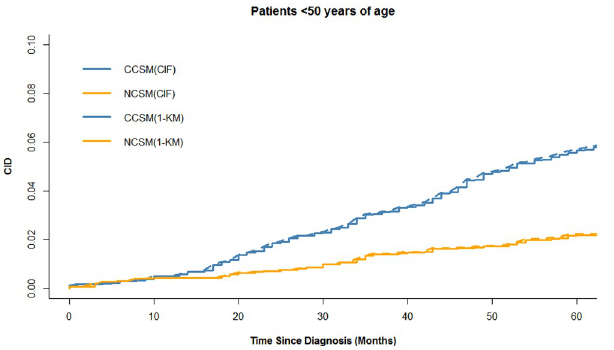
Fig 3. Cumulative incidence functions and Kaplan-Meier method estimates for patient < 50 years of age. CCSM: colon cancer-specific mortality; NCSM: noncancer-specific mortality; CID: cumulative incidence of death; CIF: Cumulative incidence functions; KM: Kaplan-Meier method.